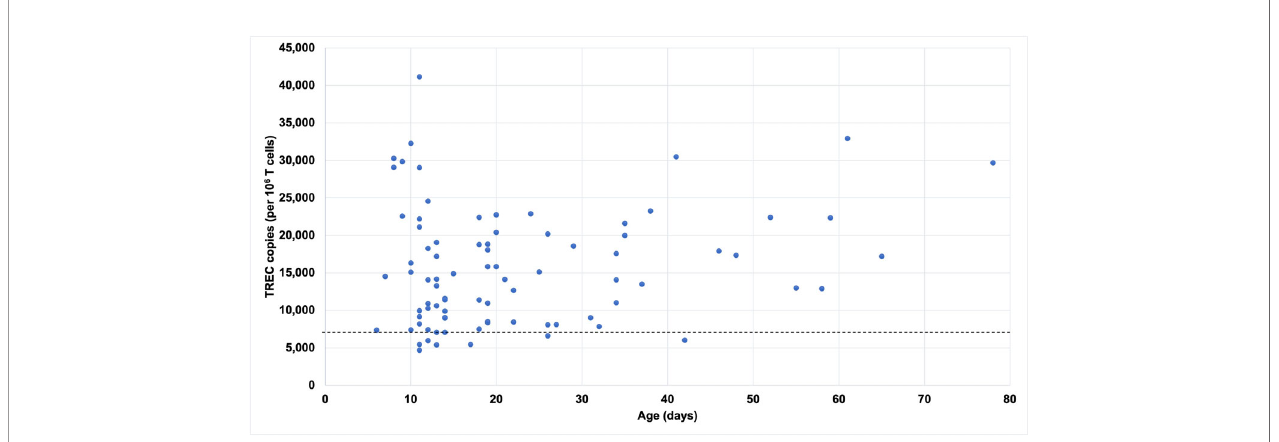
FIGURE 1 | TREC copies by age at the time of testing in term infants with abnormal SCID screens and normal CD3 + T cell count. Dashed line represents normal cutoff TREC value for term